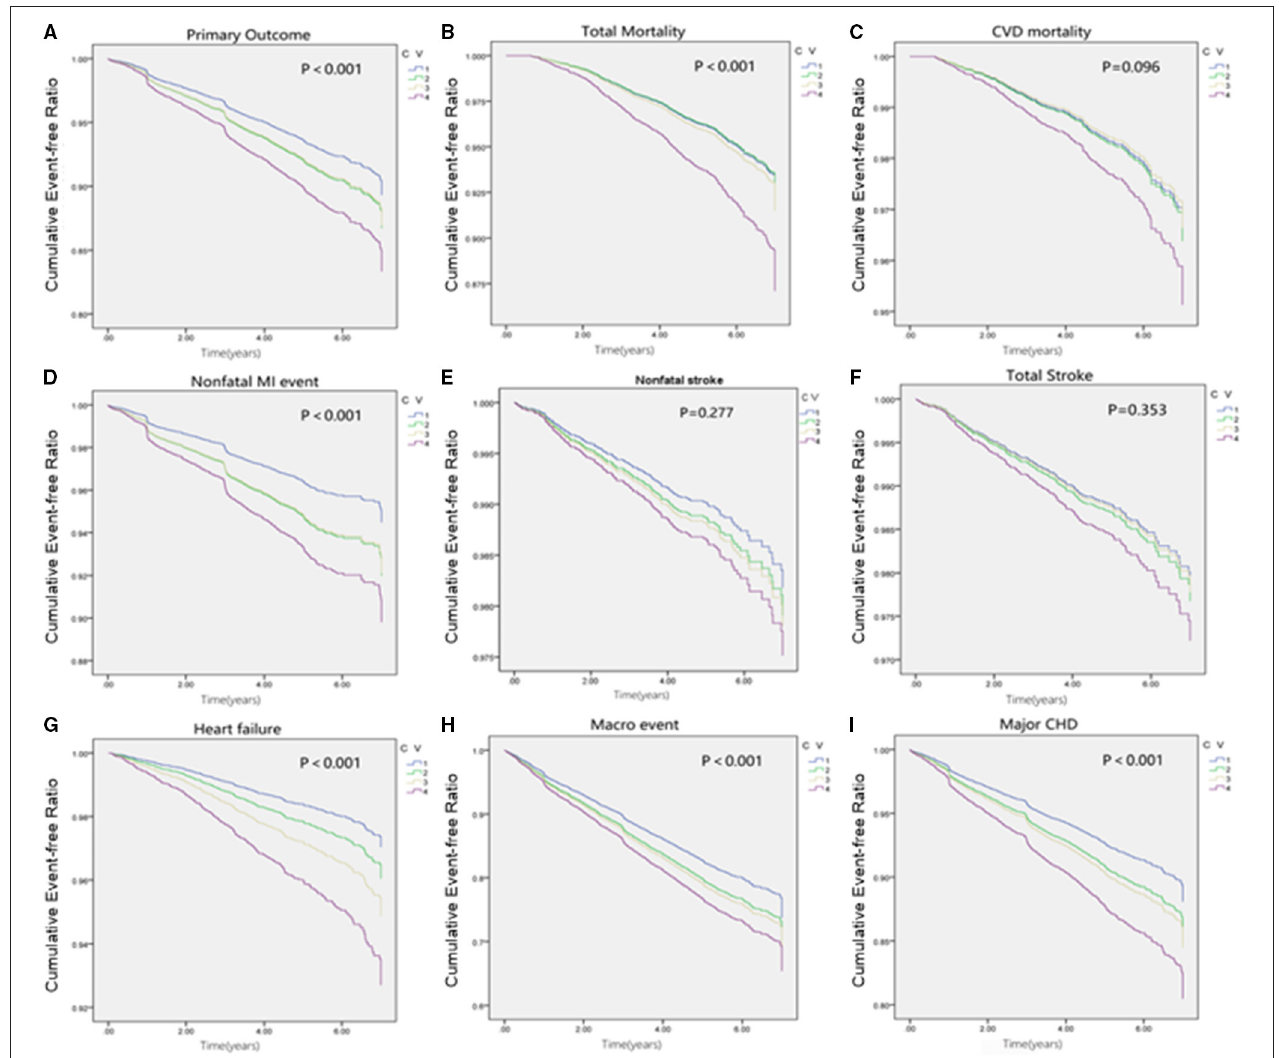
FIGURE 2 | Cumulative survival of outcomes grouped by quartiles of HbA1c fluctuation. (A) Cumulative survival of Primary outcome grouped by quartiles of HbA1c fluctuation. (B) Cumulative survival of Total mortality grouped by quartiles of HbA1c fluctuation. (C) Cumulative survival of CVD mortality grouped by quartiles of HbA1c fluctuation. (D) Cumulative survival of Non-fatal MI event grouped by quartiles of HbA1c fluctuation. (E) Cumulative survival of Nonfatal stroke grouped by quartiles of HbA1c fluctuation. (F) Cumulative survival of Total stroke grouped by quartiles of HbA1c fluctuation. (G) Cumulative survival of CHF grouped by quartiles of HbA1c fluctuation. (H) Cumulative survival of Macro event grouped by quartiles of HbA1c fluctuation. (I) Cumulative survival of Primary outcome grouped by quartiles of HbA1c